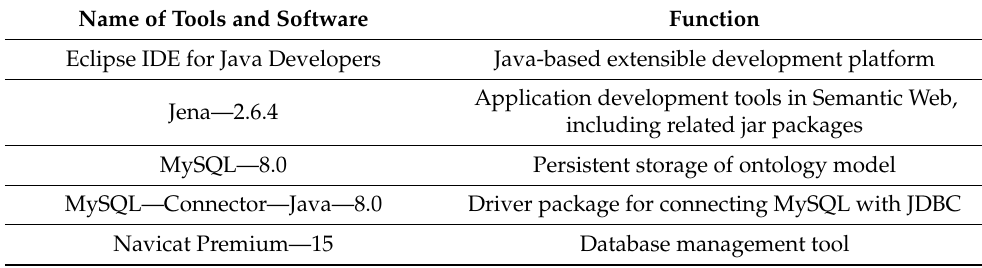
Table 13. Reasoning tools and